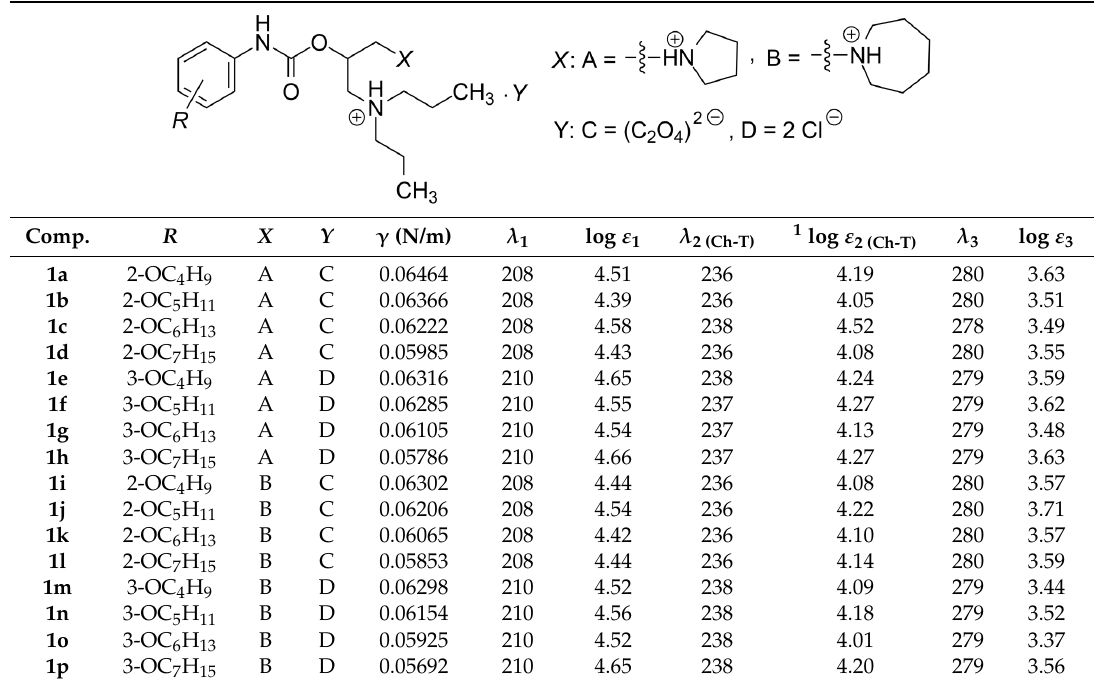
Table 1. Chemical structure of evaluated compounds 1a – p , their surface tension γ (relative surface activity; in N/m units), wavelengths of observed absorption maxima ( λ 1 , λ 2 (Ch-T) , λ 3 ) and logarithms of molar absorption coefficients (log ε 1 , log ε 2 (Ch-T) , log ε 3 ) of compounds’ methanolic solutions ( c = 8.0 × 10 − 5 M), which were investigated in the UV/Vis region of an electromagnetic